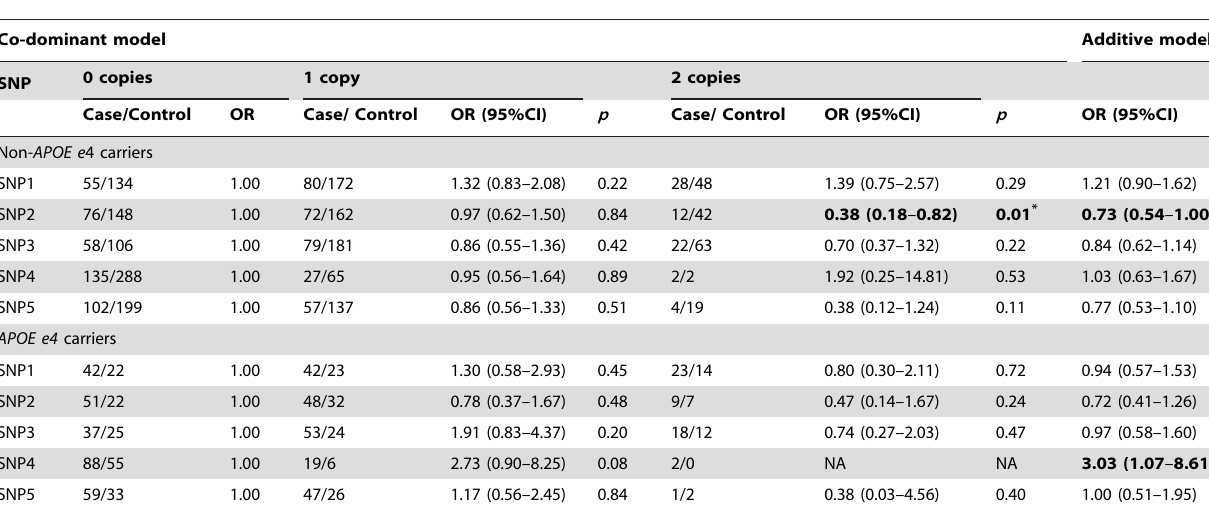
Table 4. NINJ2 SNP analysis by APOE e4 status for Alzheimer’s disease patients and controls.